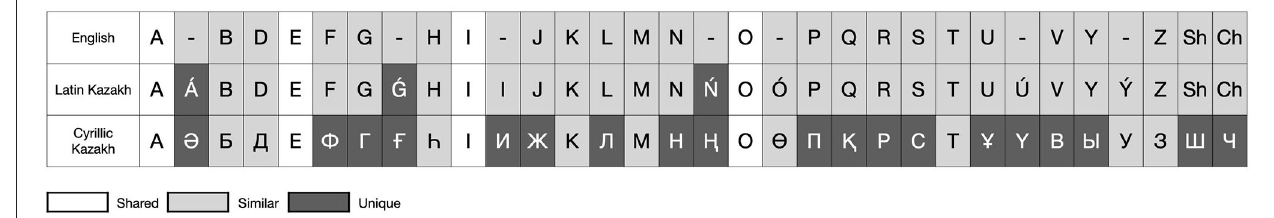
FIGURE 1 | Comparison of a new Latin-based Kazakh alphabet to English and Cyrillic-based